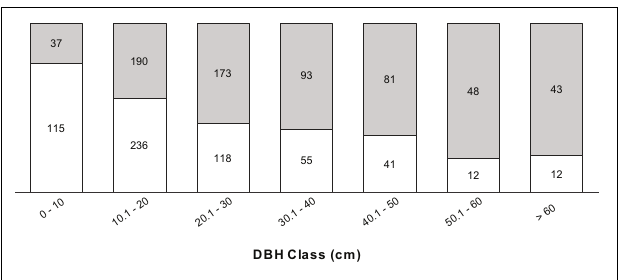
FIGURE 5 | Proportion of dead (gray) vs. alive (white) trees per DBH class of Calophyllum paniculatum in Ranomafana National Park. Numbers within columns indicate the number of individual trees in each category (dead or alive).